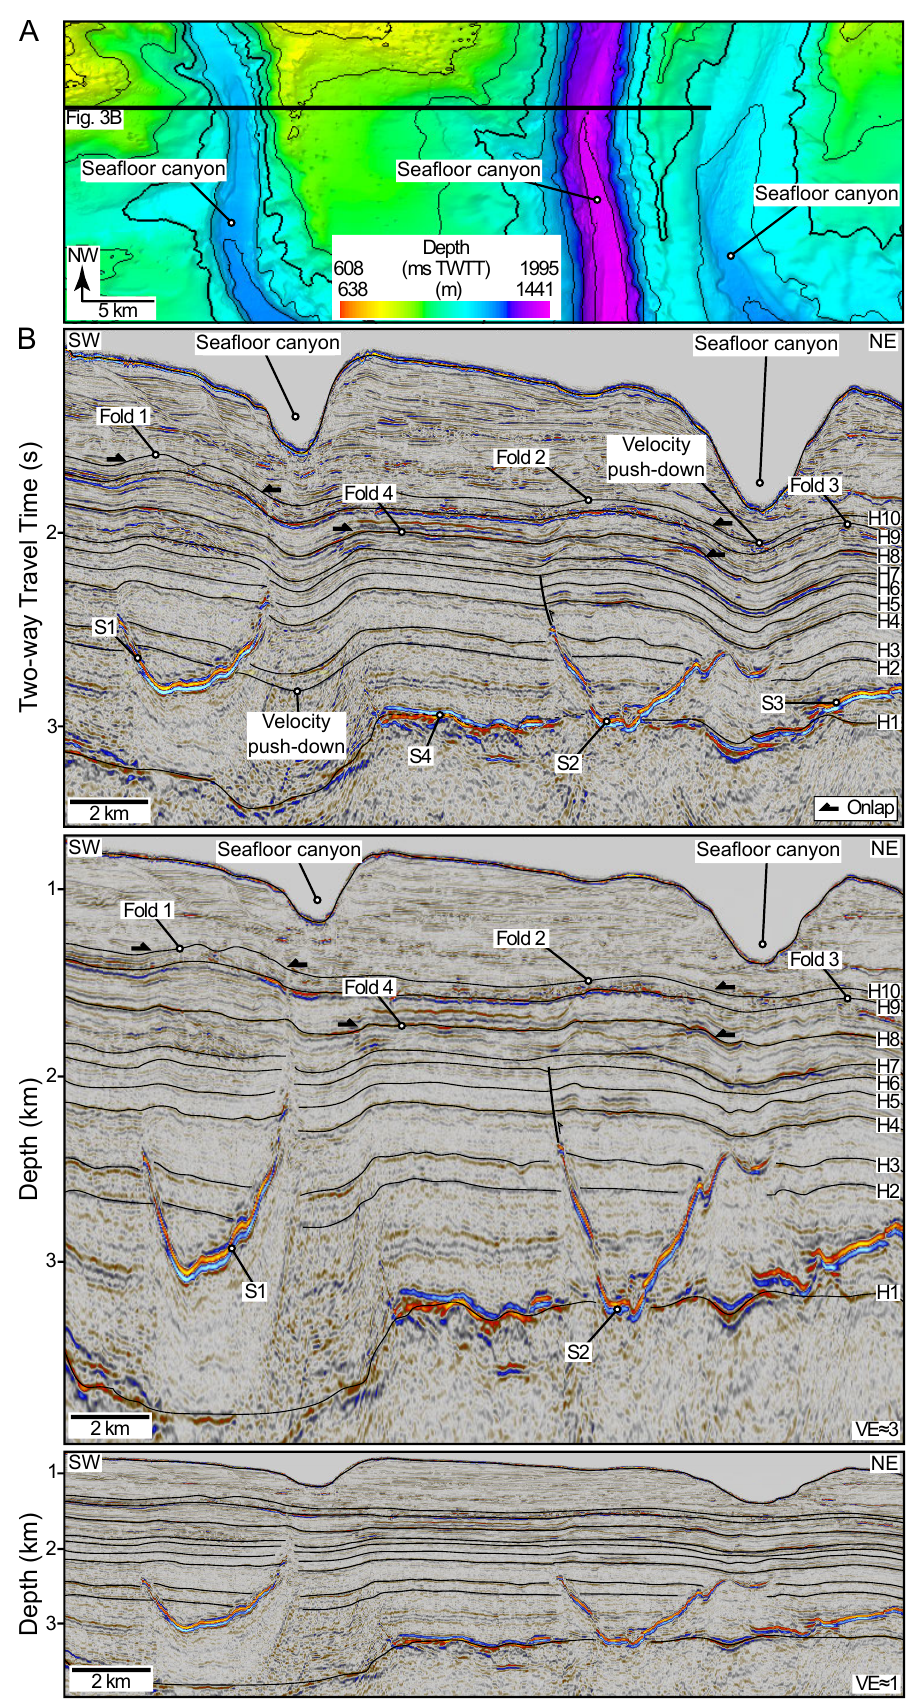
Figure 3: Caption on next